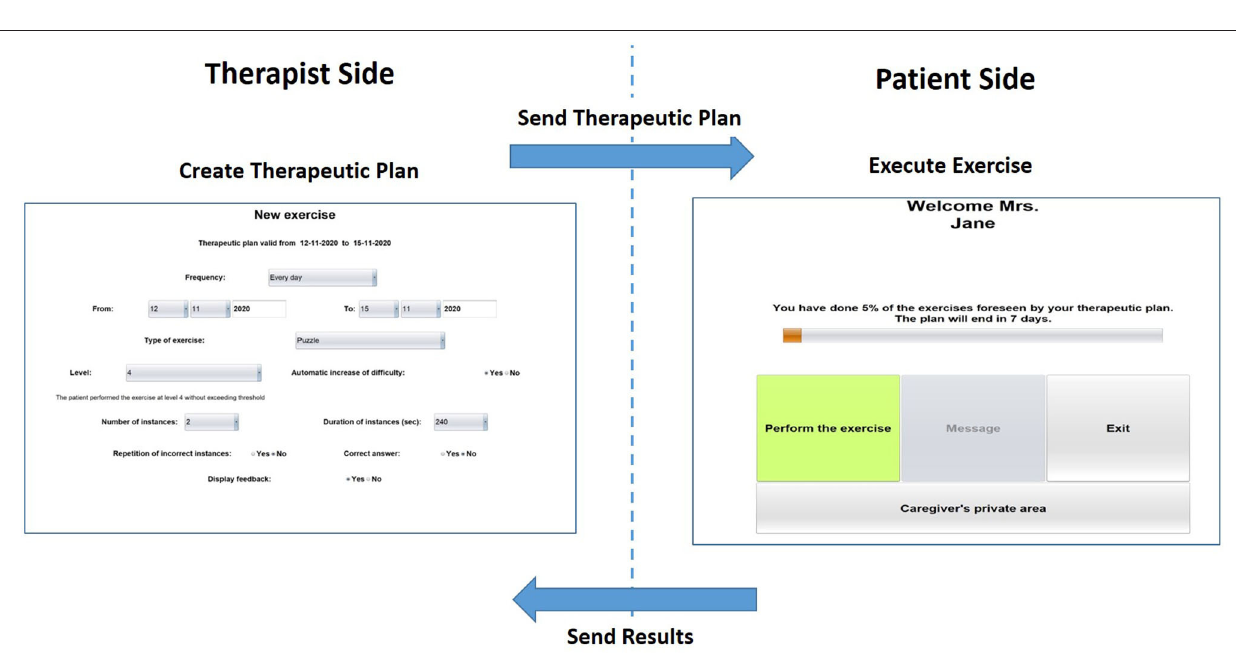
observed in the hospital setting, we recently developed a TR version of CoRe that allows the provision of treatment at patients’ homes: HomeCoRe